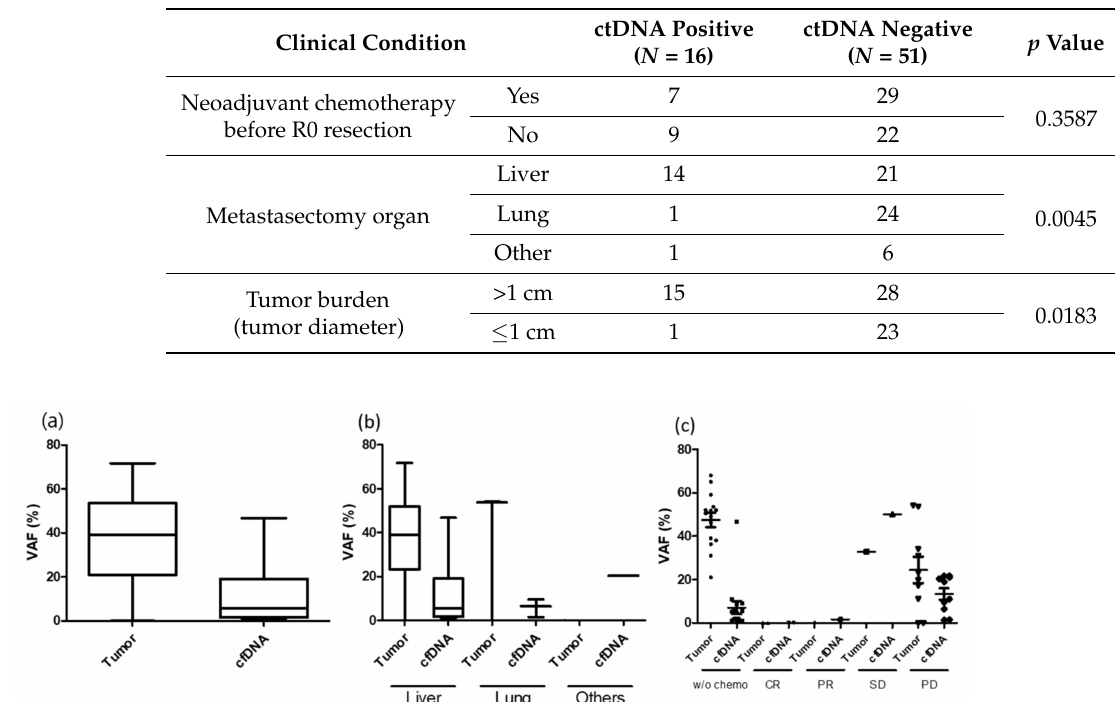
Table 6. ctDNA Detection before Metastasectomy ( N events = 67).